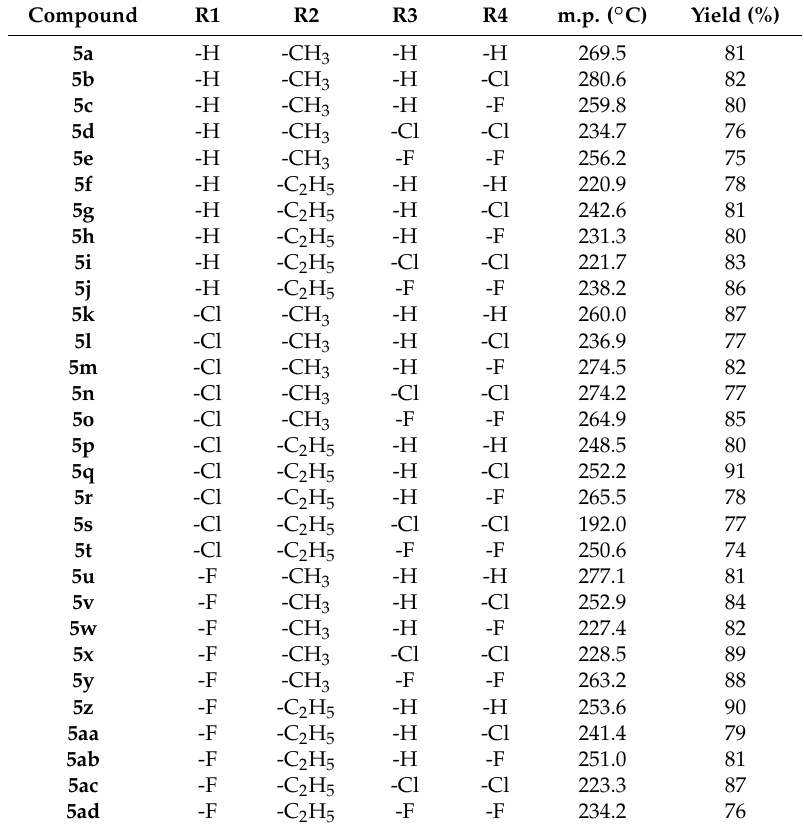
Table 1. Some characteristics of compounds ( 5a – 5ad